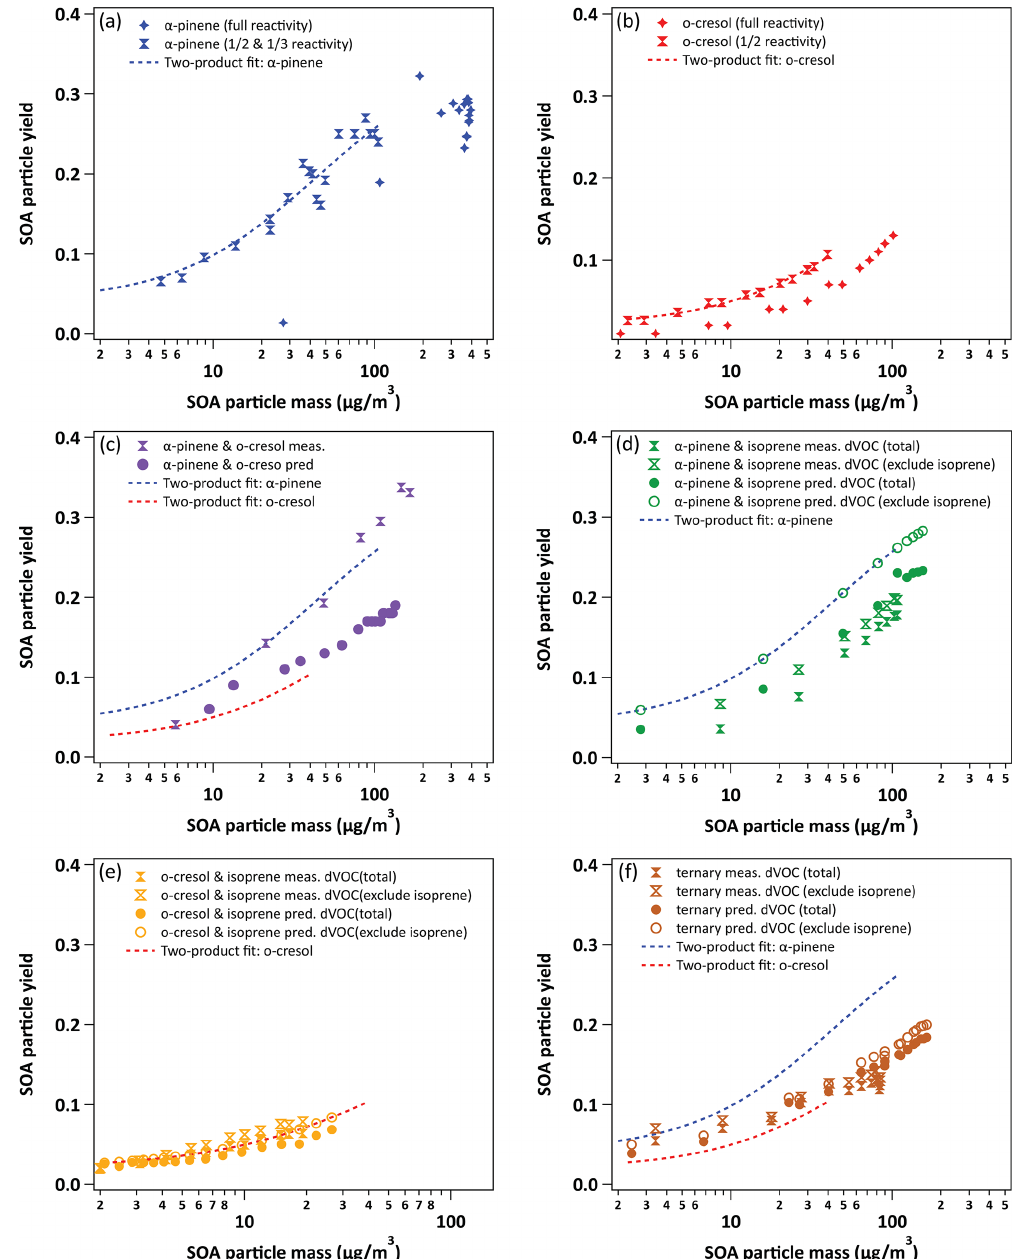
Figure 5. Yield data for selected representative experiments in all systems (with two-product yield curves for α -pinene and o -cresol single- VOC experiments). Panel (a) shows the binary α -pinene– o -cresol mixture and its constituents, (b) the binary α -pinene–isoprene mixture, (c) the o -cresol–isoprene mixture (expanded y -axis plot shown in Fig. S5), and (d) the ternary α -pinene– o -cresol–isoprene mixture. Yields “predicted” from the linear combination of yields from the individual VOC experiments using Eq. (4) are shown for each